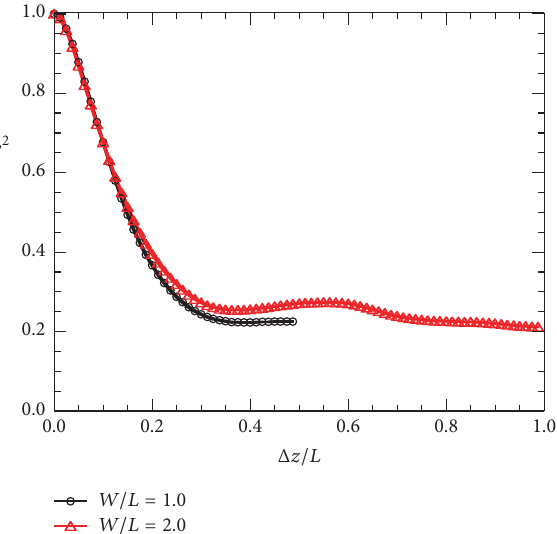
Figure 9: Predicted coherence of velocity, V /𝑈 ∞ , at fundamental frequency in spanwise direction ( 𝑥/𝐿 = 0.5 and y = 0) for cavity flow ( 𝐷/𝐿 = 0.5) with original and wider computational domains of 𝑊/𝐿 = 1.0 and